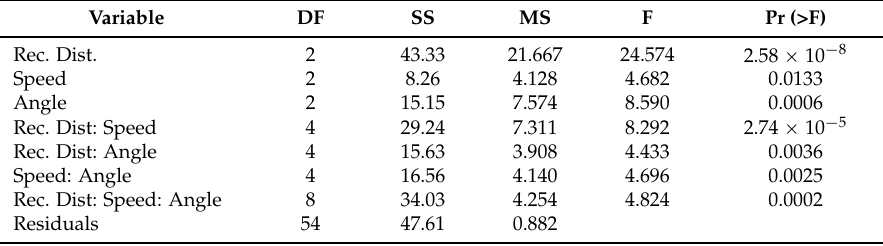
Table 1. ANOVA results for full model including all main and interaction effects.